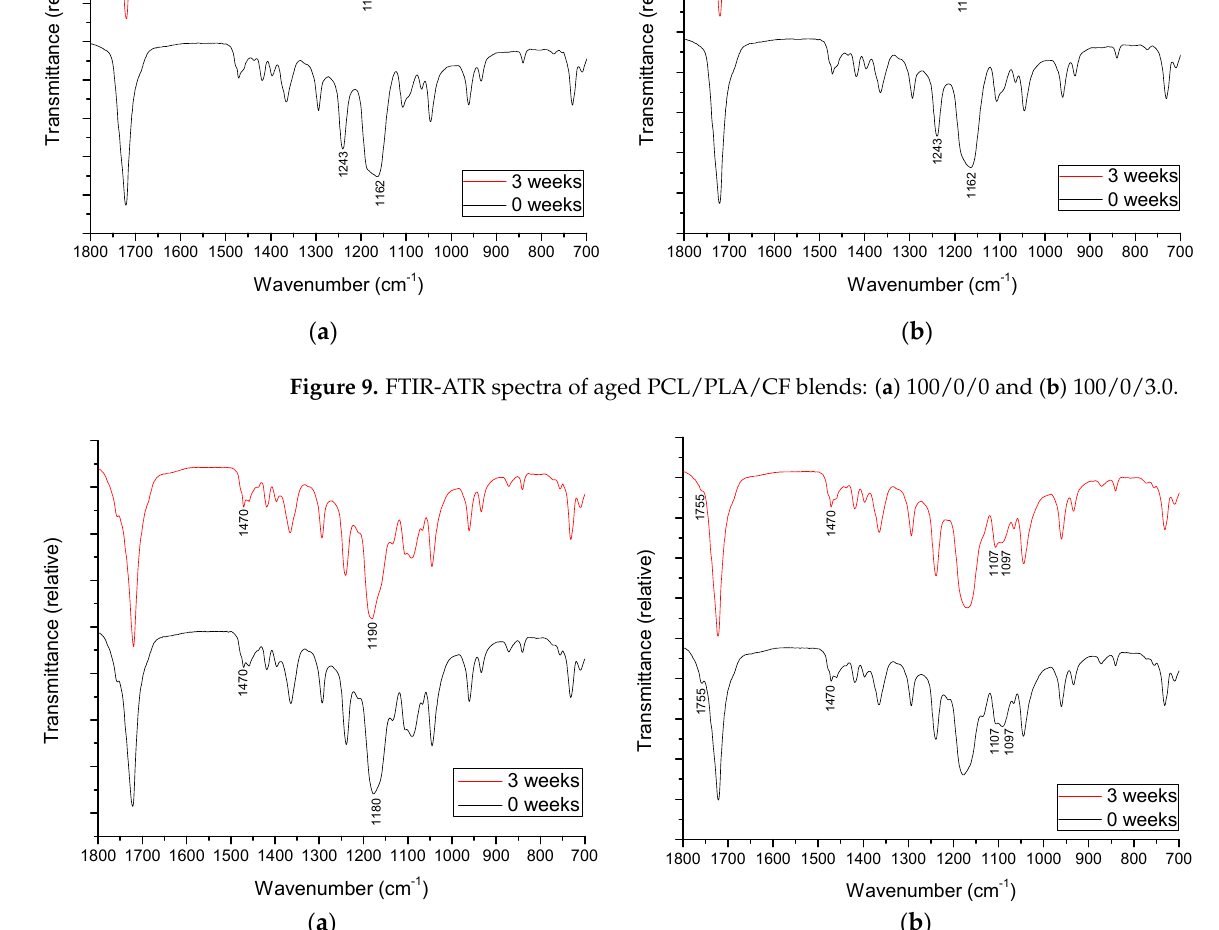
Figure 10. FTIR-ATR spectra of aged PCL/PLA/CF blends: ( a ) 70/30/0 and ( b ) 70/30/3.0.